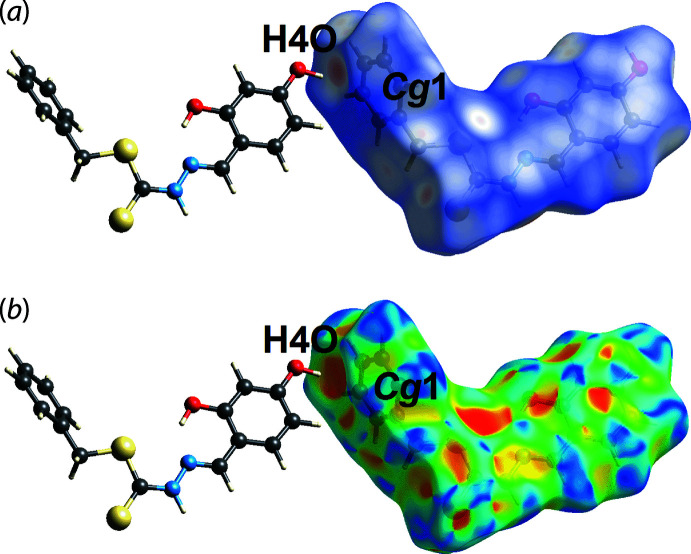
A view of the Hirshfeld surface mapped over (a) d
norm and (b) the shape-index property highlighting the inter­molecular hydroxyl-O—H⋯π(phen­yl) contacts as red and dark-orange regions, respectively.